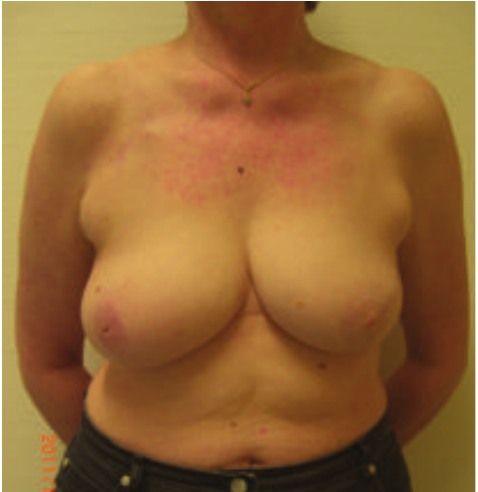
Figure 9: Same patient, 18-month follow-up, frontal view; scar length 27 cm; BCCT.core: fair. The patient was very satisfied with the cosmetic result. The scar visibility was rated as slightly visible by the patient and moderately visible by the experts. The volume discrepancy was rated as slight by the patient and